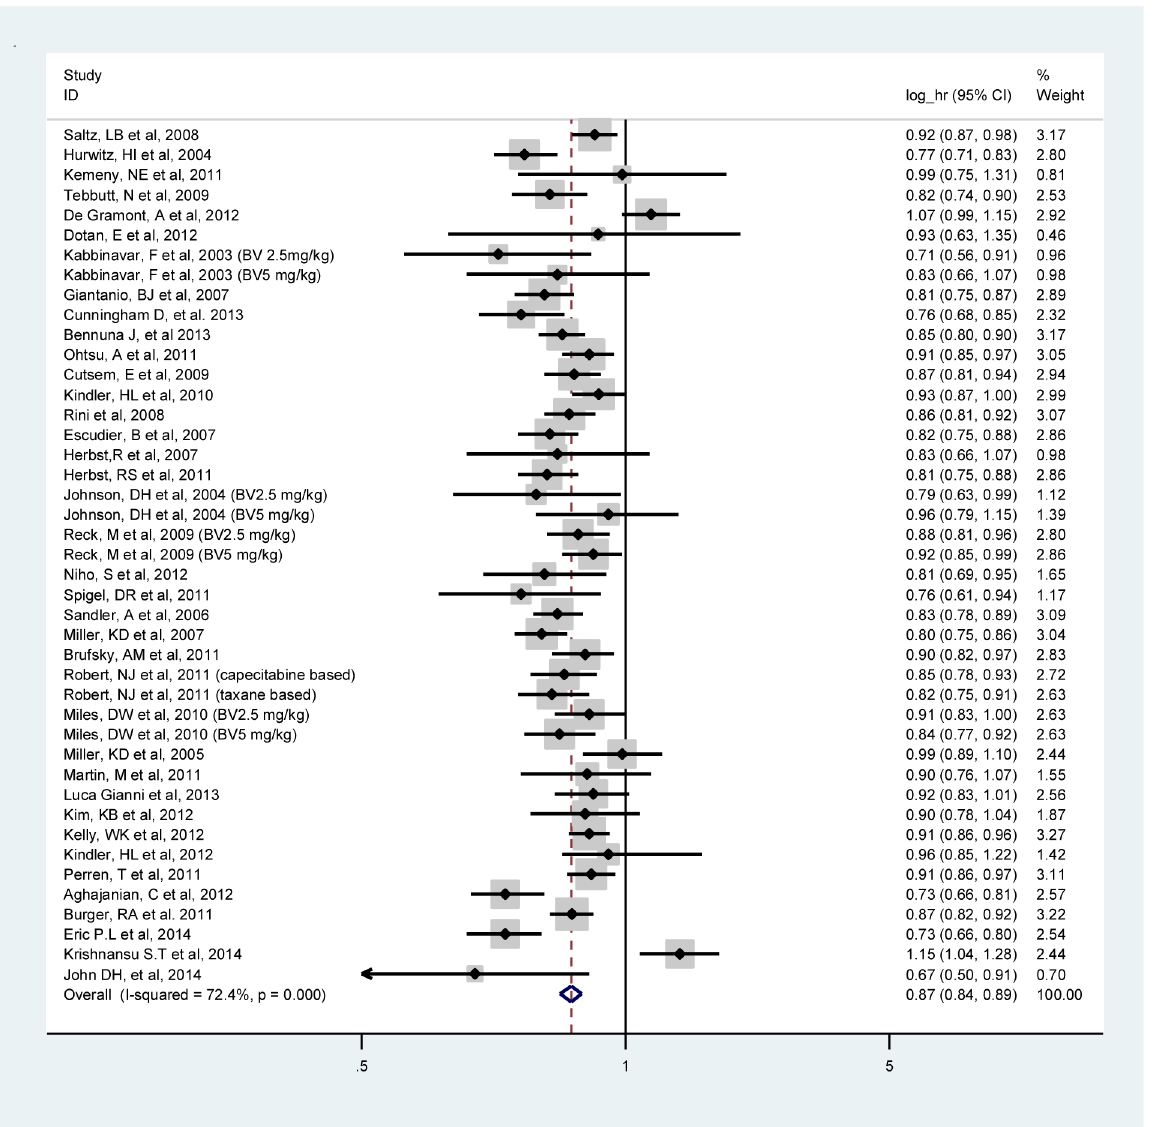
Fig 2. Meta-analysis of the log hazard ratios of progression free survival comparing bevacizumab and standard therapy in all trials combined.